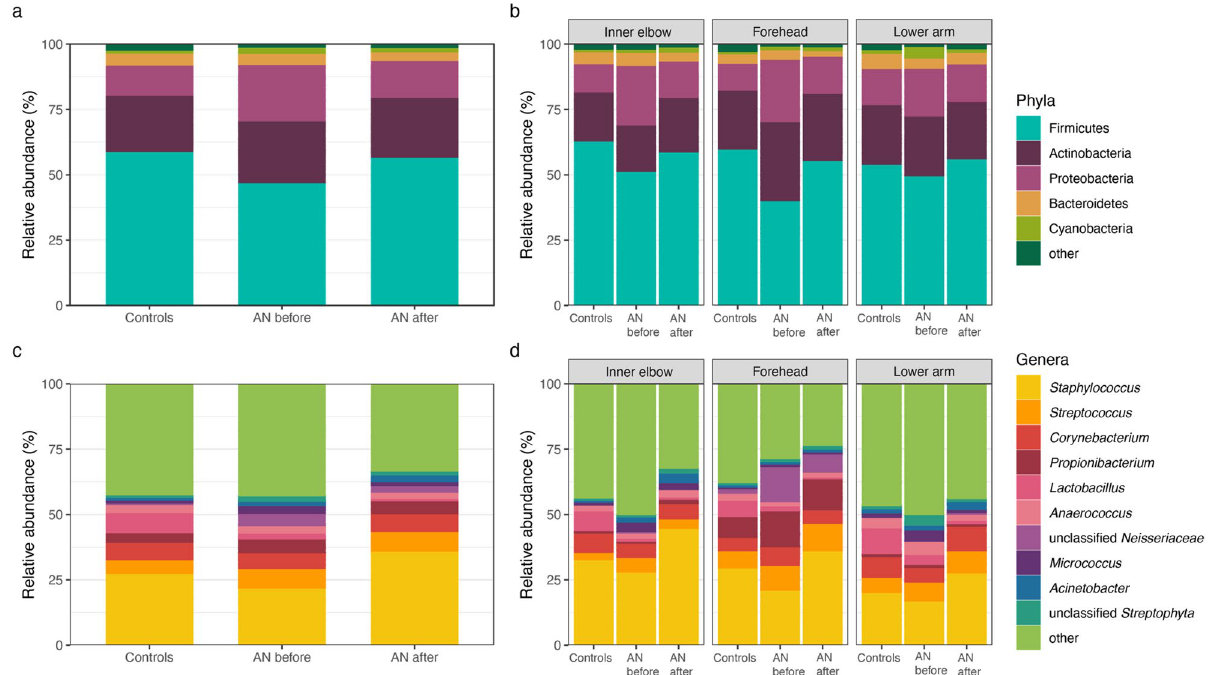
Figure 3. Overview of dominant taxa at sampling sites. ( a ) Bar plot of relative abundances for the most abundant phyla, and ( b ) at sampling sites (inner elbow, forehead, and lower arm). ( c ) Bar plot of relative abundances for the most abundant genera, and ( d ) at sampling sites (inner elbow, forehead, and lower arm). AN anorexia nervosa, Controls healthy-weight controls, AN before patients with AN before weight gain treatment, AN after patients with AN after weight gain